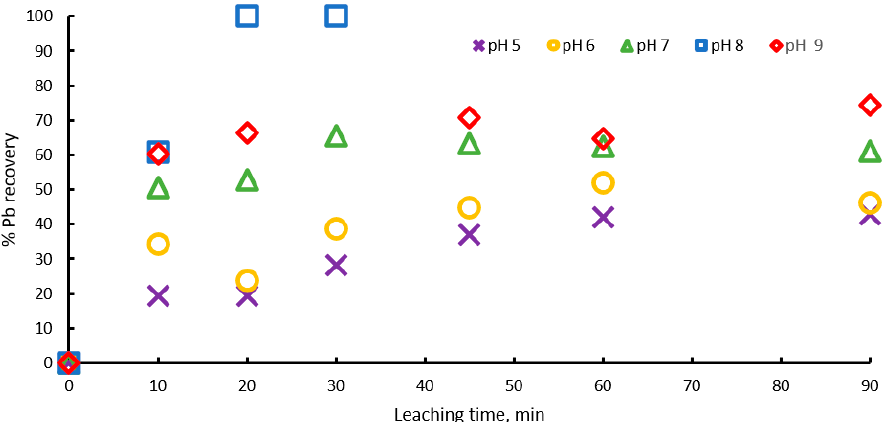
Figure 3. Effect of pH on lead dissolution from pure galena at 20 ◦ C. Experimental conditions: particle size: − 149/+74.1 g of mineral, 0.1 L of solution, 1.0 M Na 3 Cit, 0.6 M H 2 O 2